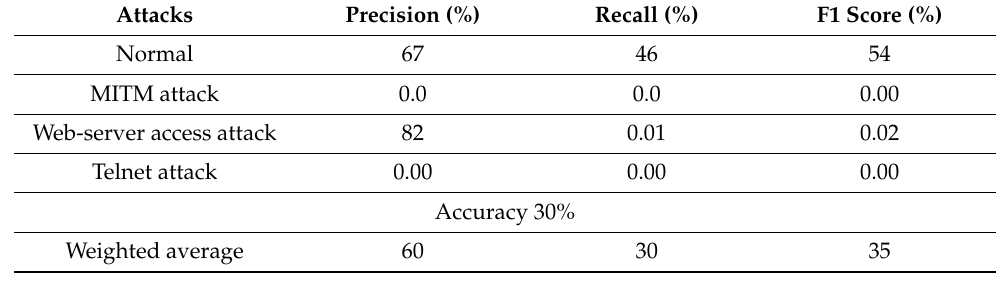
Figure 8. Performance and loss accuracy of the CNN-LSTM model using the binary dataset. ( a ) model accuracy ( b ) model loss